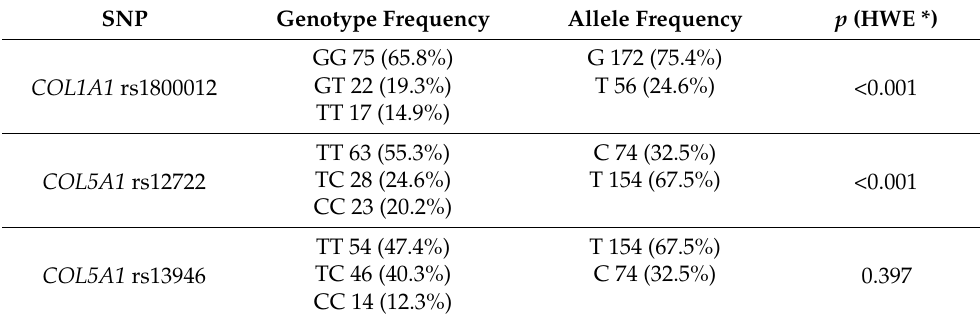
Table 1. Genotype and allele frequencies of the COL1A1 and COL5A1 polymorphisms. SNP